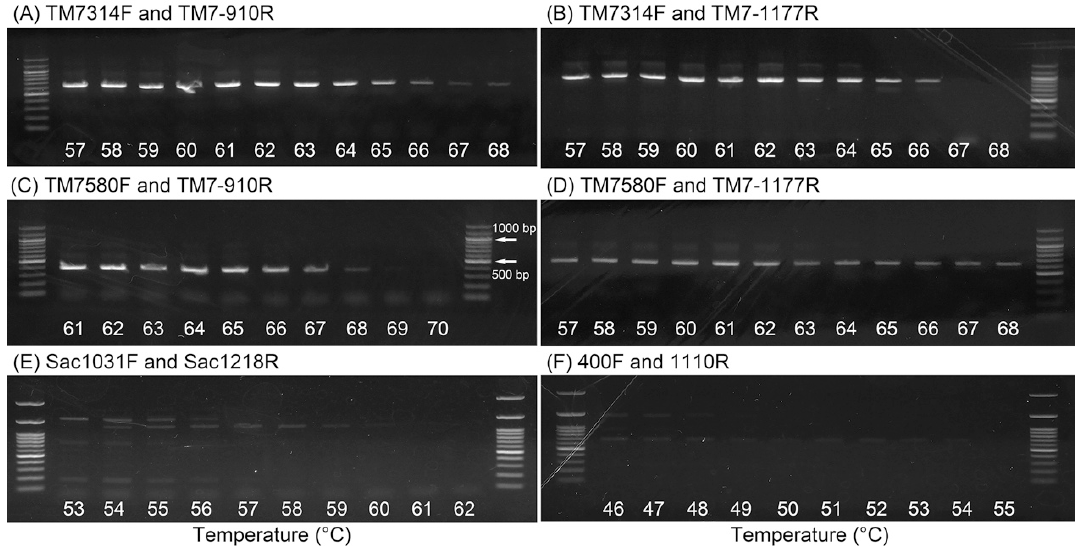
Figure 1. Agarose gel electrophoresis pattern of the PCR products using the following primer sets: TM7314F and TM7-910R ( A ), TM7314F and TM7-1177R ( B ), TM7580F and TM7-910R ( C ), TM7580F and TM7-1177R ( D ), Sac1031F and Sac1218R ( E ), and 400F and 1110R ( F ).